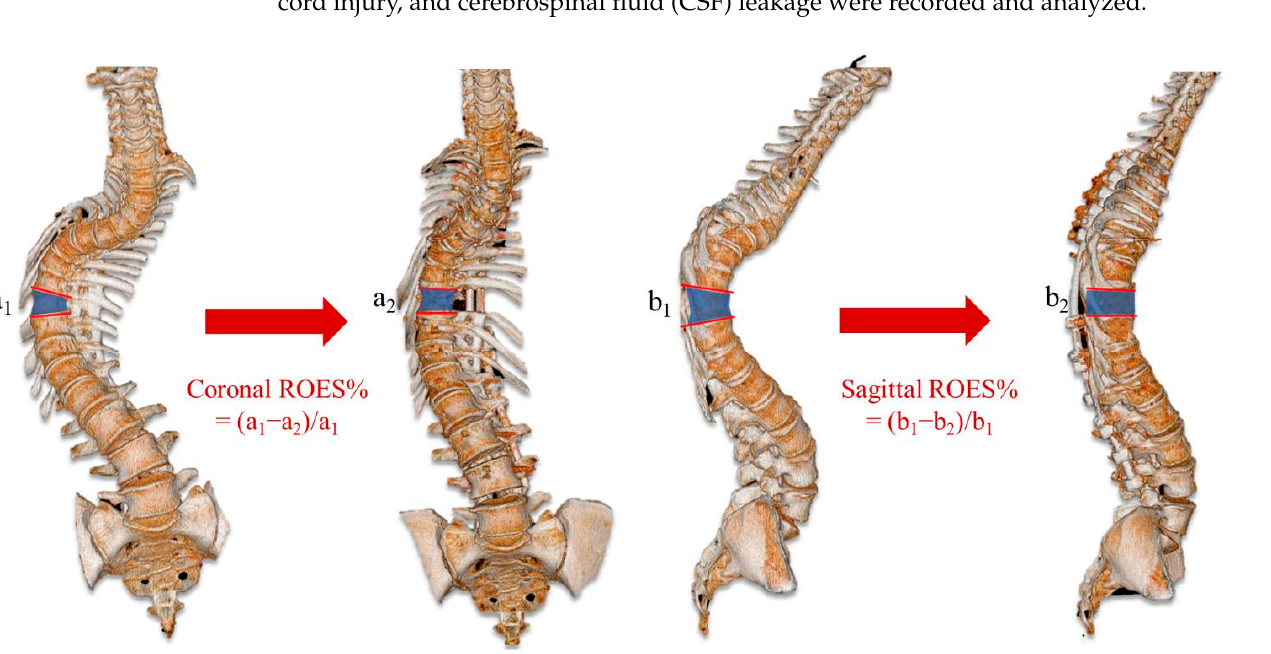
Figure 6. The ratio of osteotomy execution and simulation.